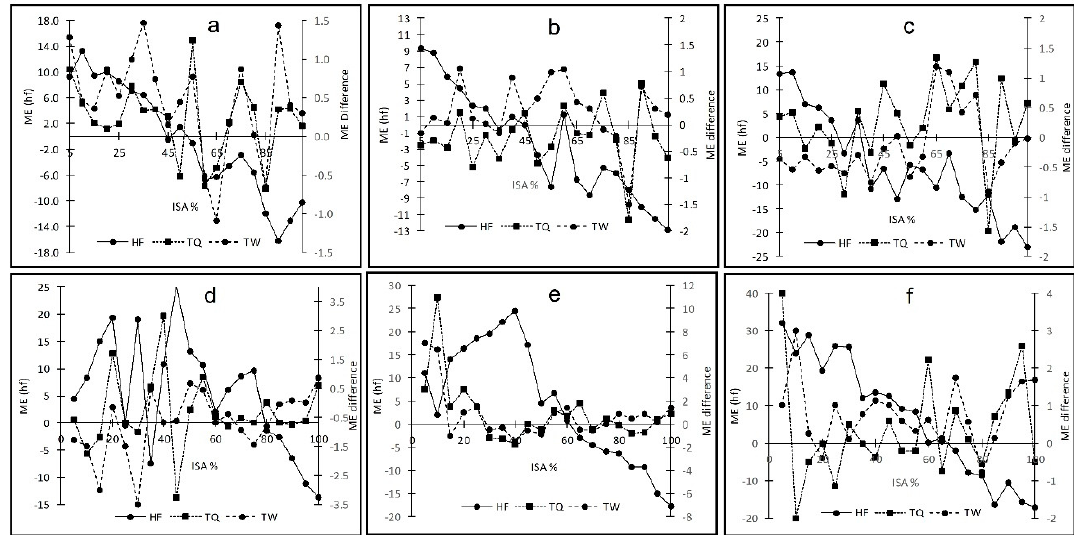
Figure 10. Mean error (ME) in impervious surface estimates derived from different SNR images in Beltsville ( a – c ) and in San Francisco ( d – f ). ME values were averaged for every 5% of imperviousness. The left y-axis is for ME from images with HF SNR and the right y-axis is for ME differences between estimates from TQ and HF SNR images (TQ-HF: short dashed lines) and from TW and HF SNR images (TW-HF: long dashed lines). The x-axis is the ISA in percent. Panels from the left to the right are the results from 10-m, 20-m, and 30-m estimates.